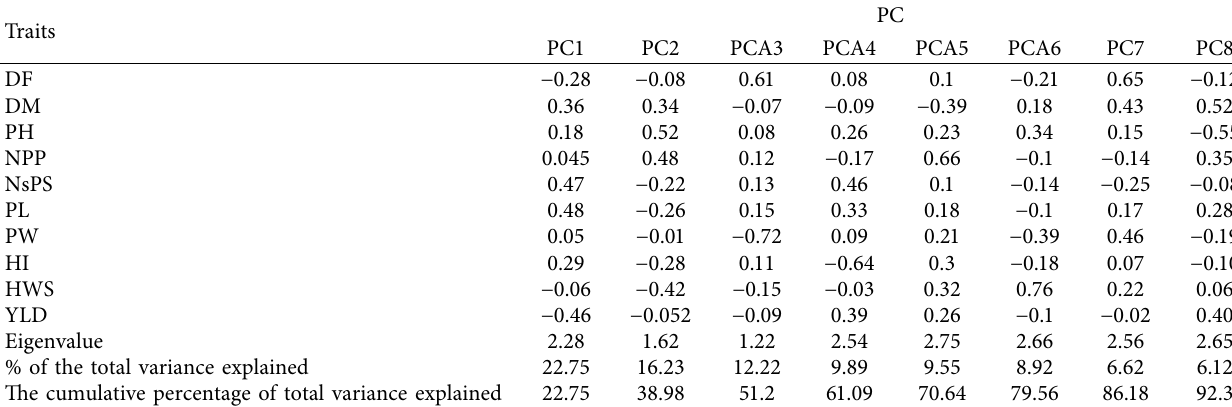
Table 10: Pair-wise generalized squared distance (D 2 ) among 100 common bean genotypes in seven clusters (2020/21). Cluster